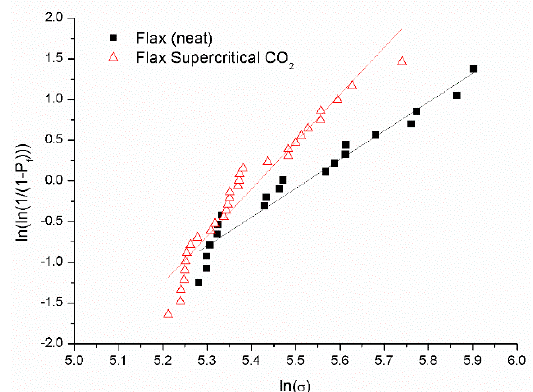
Figure 5. Weibull distribution plots for strength measured for untreated and supercritical CO 2 treated flax yarns.